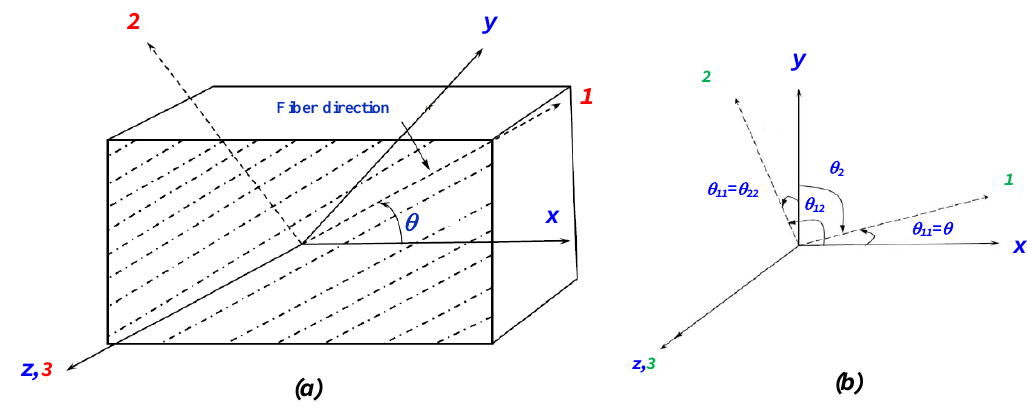
Figure 1. ( a ) Schematic of a unidirectional orthotrophic composite laminate with principal material co-ordinate system (1,2, and 3) and global co-ordinates ( x , y , and z ). ( b ) Principal material axis 3 is rotated by θ in x − y plane with anticlockwise angle with respect to x -axis is taken as